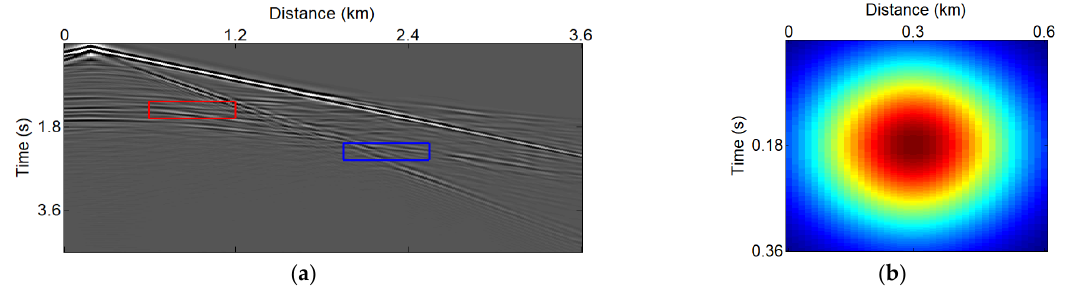
Figure 1. ( a ) Horizontal component of the measured elastic seismic data; ( b ) 2-D window.